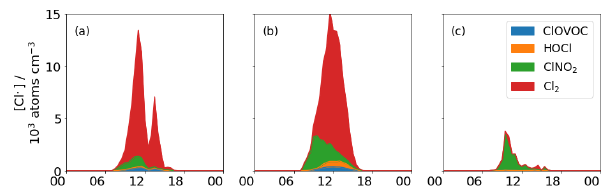
Figure 6. Steady state concentration of Cl from ClNO 2 , Cl 2 , HOCl and total ClOVOC photolysis for (a) 1 November, (b) 5 November, and (c) 7 November. The importance of ClNO 2 during the morning is most evident on the 5, with a diminishing contribution throughout the day. On the high-flux days, Cl 2 is the most important source of Cl, but on the low-flux day, ClNO 2 is most